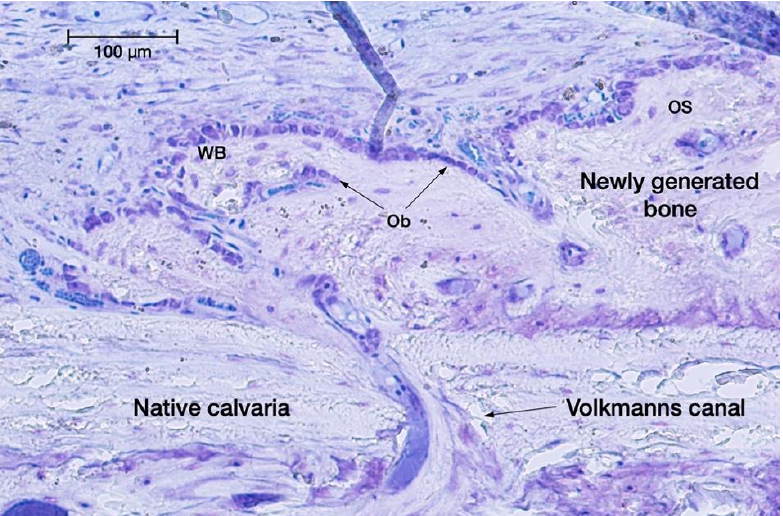
Figure 3. Spontaneous opening of a Volkmann's canal, letting osteogenic cells migrate from the medullary spaces towards the native skull bone into the regeneration chamber for extra-skeletal new bone formation. Toluidine blue staining (original magnification: 20×). The percentage of lamellar bone was lower in the two non-perforated groups (C: 12.99 ± 2.81%; test group II: 17.36 ± 5.99%) than in the perforated groups (test group I: 22.16 ± 7.47%; test group III: 31.84 ± 9.55%). A similar distribution was found for woven bone: non-perforated groups C 10.24 ± 2.58% and II 12.79 ± 4.20% vs. perforated test groups I 17.31 ± 3.91% and III 16.27 ± 5.20%. The higher values of woven bone indicate more advanced maturity of bone formation. Early bone marrow structures were visible in some specimens. At this point, these were more pronounced in the groups treated with minocycline (test group II: 1.19 ± 1.72%; test group III: 3.41 ± 3.29%) and up to 400% higher than in the two non-treated groups (C: 0.36 ± 0.65%; test group I: 0.69 ± 1.15%), but re- mained marginal on the whole. The higher bone marrow values in the minocycline groups also indicate more advanced organisation of the already formed bone. The detailed histo- morphometric quantifications of the different structures and tissues are summarised in Table 2. Overall, the perforated groups showed a larger extent of mineralisation (test group I: 40.16 ± 9.86%; test group III: 51.51 ± 9.06%) compared to the unperforated control group (23.59 ± 4.04%) and test group II (31.33 ± 6.44%; Figure 4). Figure 4. Increase in bone thickness over time. Both the perforation procedure and minocycline ad- ministration resulted in an increase in bone thickness, with the strongest effect in the combination